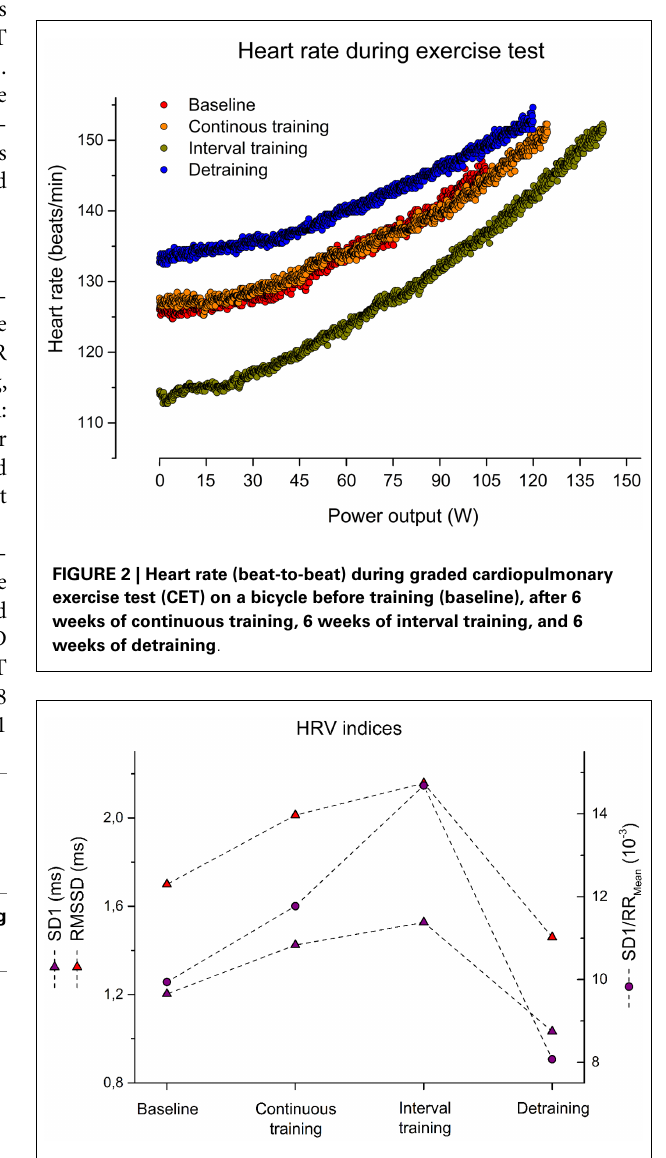
FIGURE 3 | Root mean of squared successive difference – RMSSD, instantaneous variability – SD1, and SD1 normalized by mean RR – SD1/RR Mean are shown for the patient before training (baseline) after 6weeks of continuous training, 6weeks of interval training, and 6weeks of detraining